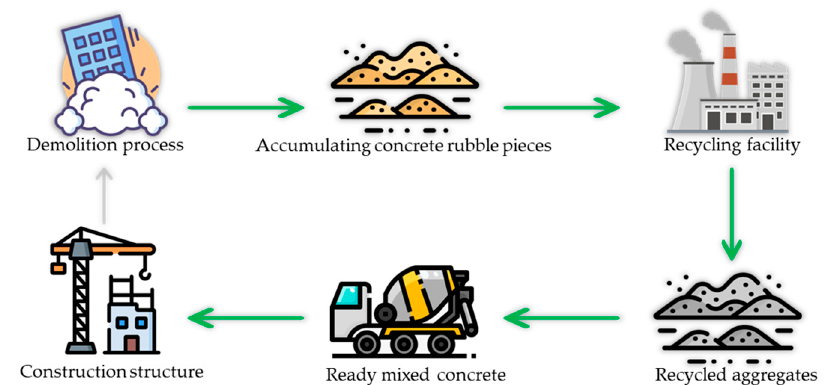
Figure 1. Production cycle of recycled aggregate concrete.